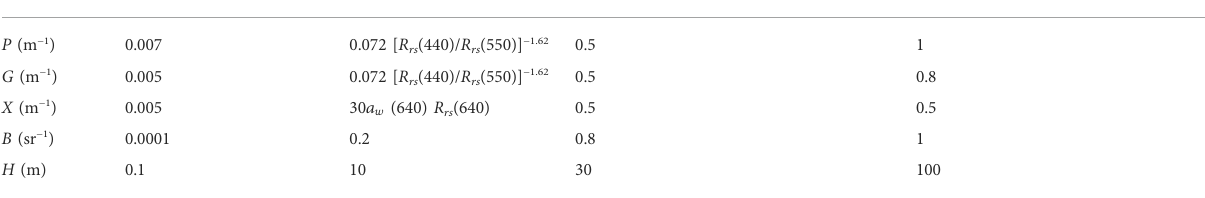
TABLE 2 Optimization constraints and initial estimates for the optimization process of the HOPE model on R rs ( λ ) in situ and PRISMA